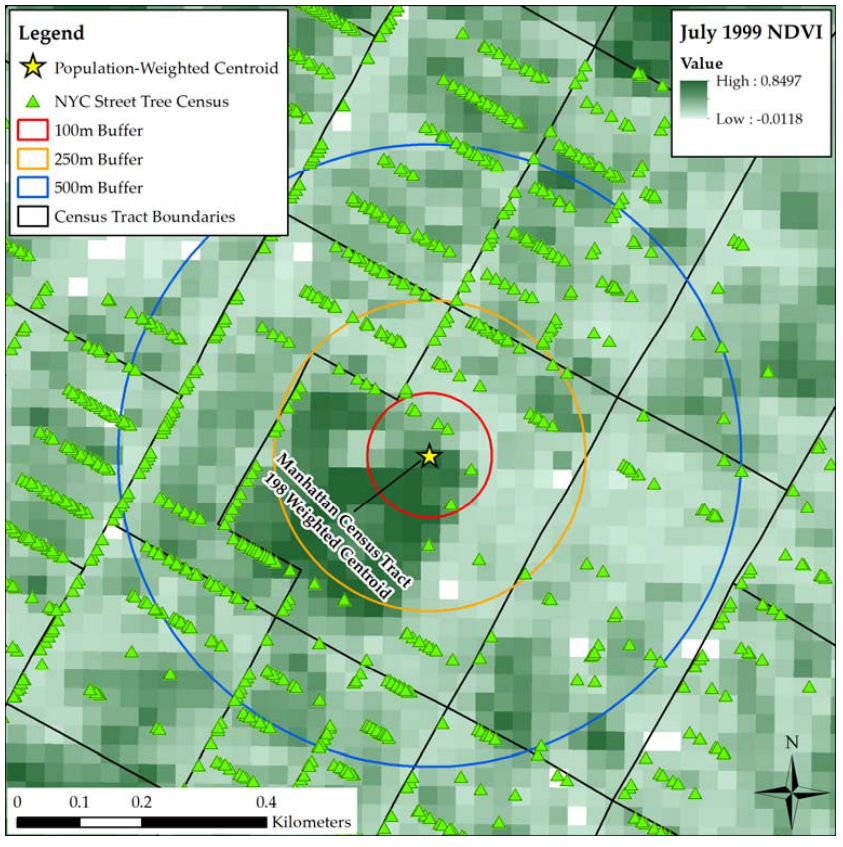
Figure 2. Example measures of greenness exposure.